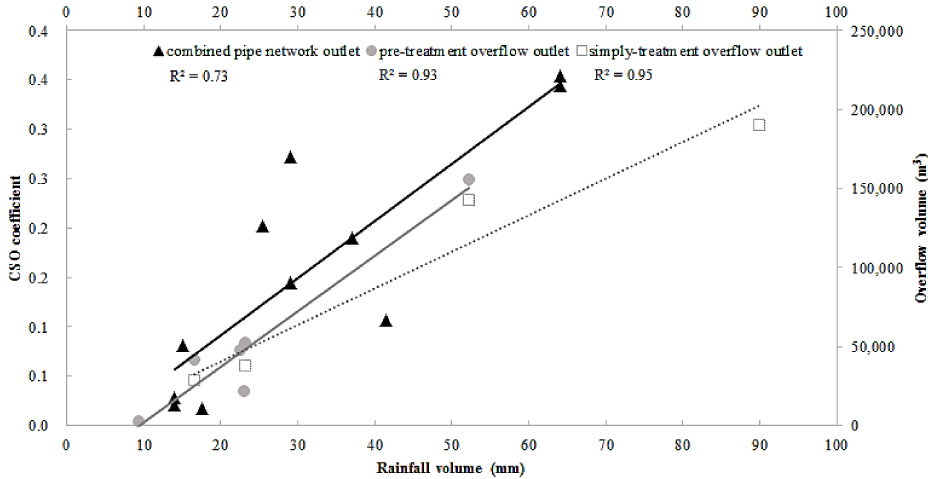
Figure 5. Fitting curve of rainfall with CSO coefficient, CSO0 overflow, and W1 overflow.